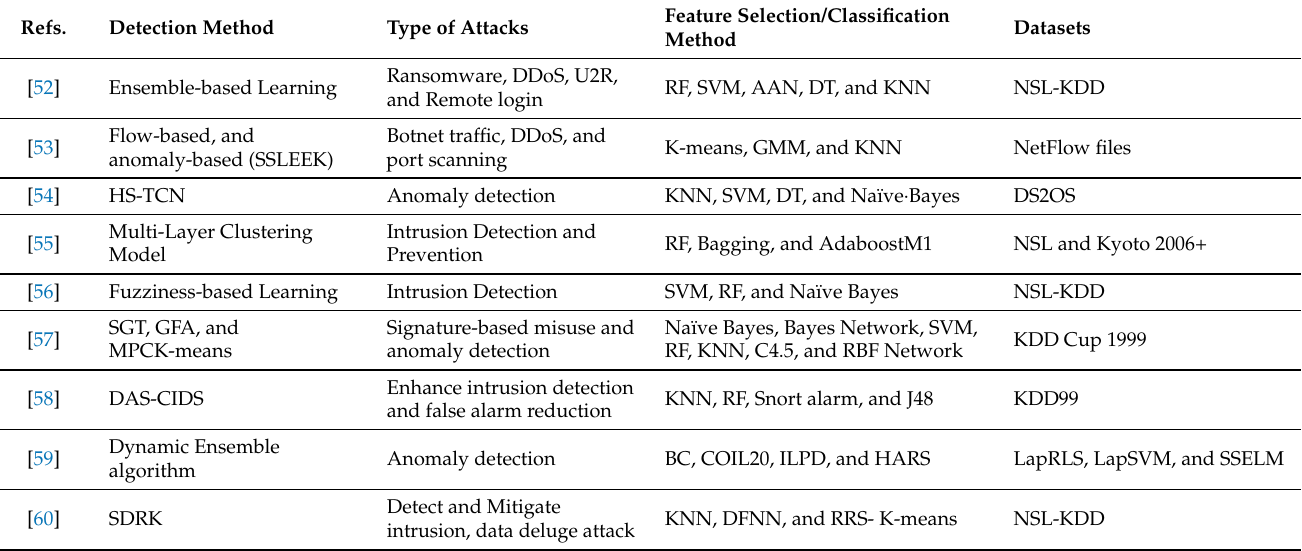
Table 4. Summary of semi-supervised machine learning methods for cyber attack detection in IoT.